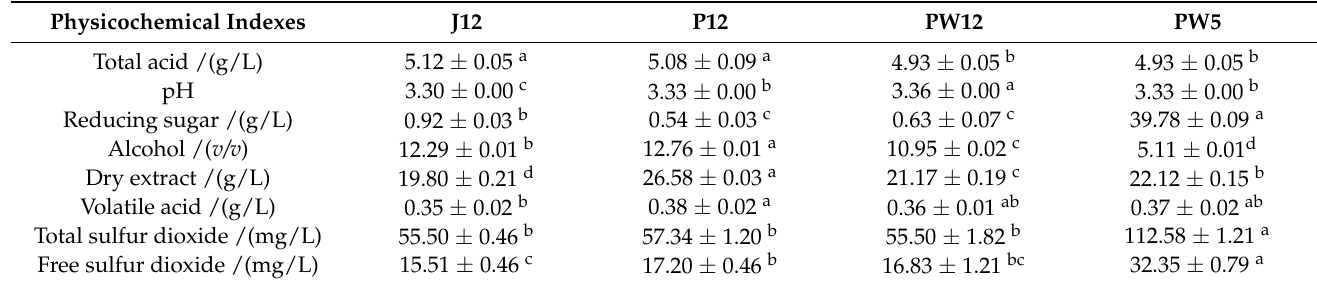
Table 1. Physicochemical properties of the investigated